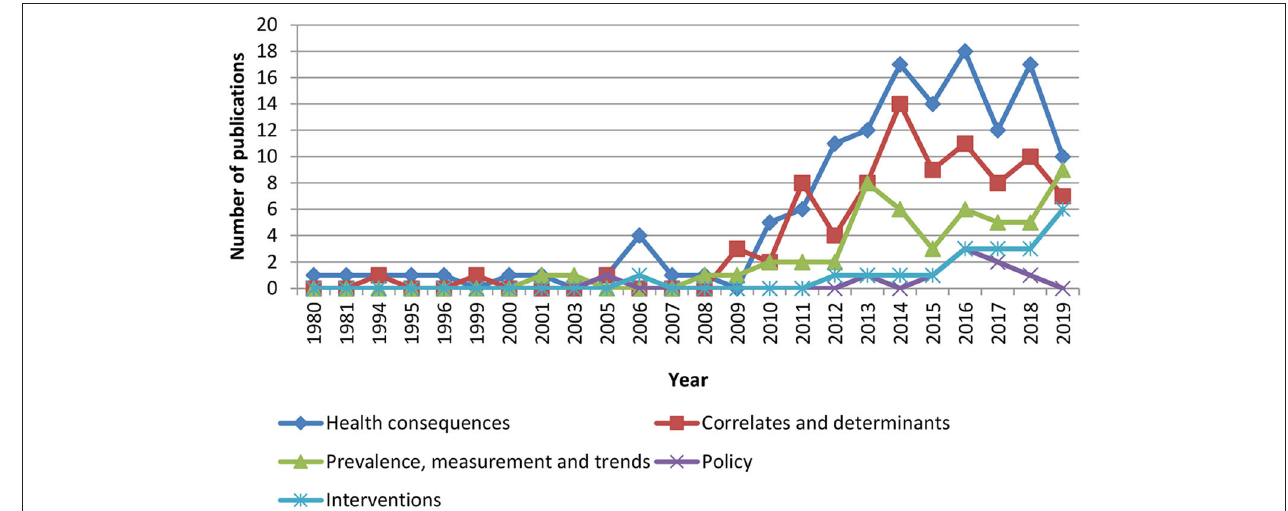
FIGURE 1 | Types of physical activity research publications in Malaysia from 1980 to